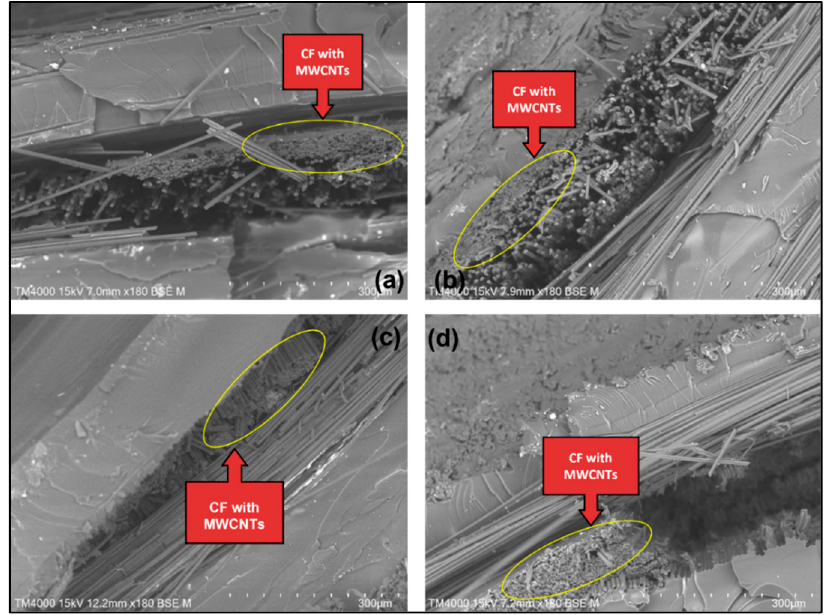
Figure 6. SEM images of CNT–CF/epoxy composites when deposition voltage is 10 V and deposition time is 5 min: ( a ) 0% water, ( b ) 20% water, ( c ) 80% water, ( d ) 100% water.